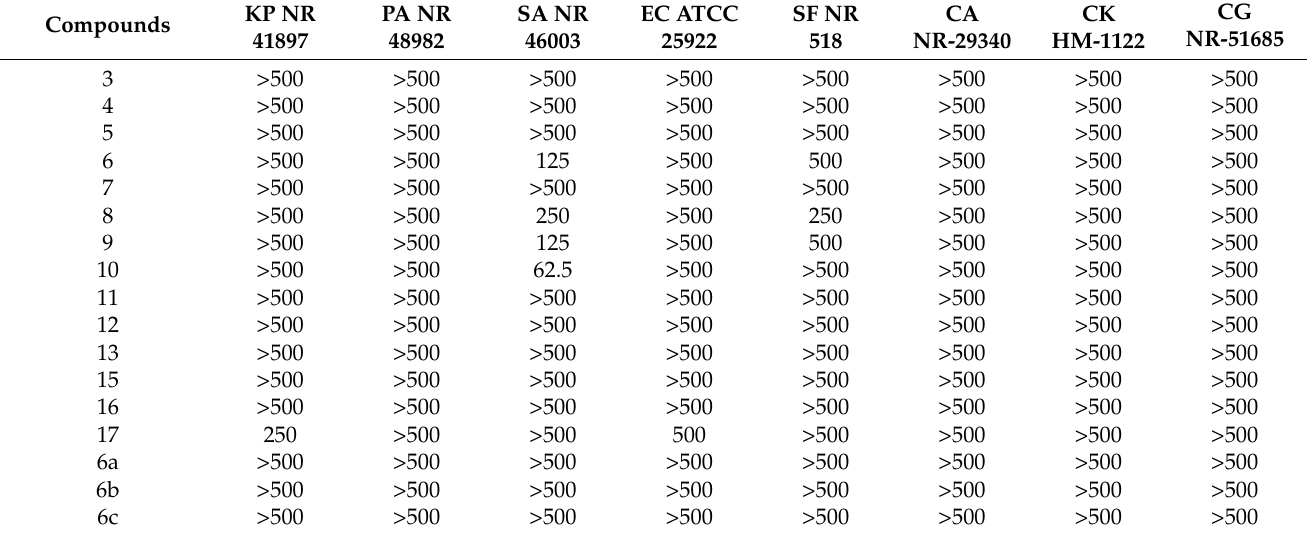
Table 1. Minimum inhibitory concentrations (MICs) ( µ g/mL) of compounds 3 − 13 , 15 − 17 , and 6a − c